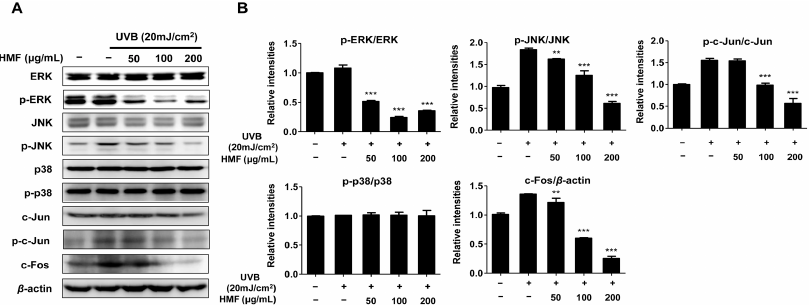
Figure 4. Effects of 3,5,6,7,8,3 ′ ,4 ′ -heptamethoxyflavone (HMF) on mitogen-activated protein kinase (MAPK) signaling components in HDFn cells. HDFn cells were treated with HFM (50, 100, and 200 μ g/mL) for 24 h following treatment with UVB irradiation (20 mJ/cm 2 ). Cellular protein levels were examined using ( A ) western blot analysis and ( B ) relative expression levels were calculated using the TL-100 software program (TotalLab, Newcastle, UK). Values are means ± standard deviation (SD) of three independent experiments. Statistical significance of differences was evaluated using one-way analysis of variance (ANOVA) followed by Tukey’s test. ** p < 0.01 and *** p < 0.001 versus HDFn cells without HMF treatment.